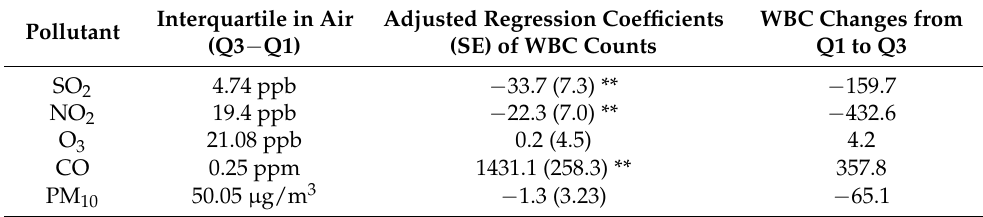
Table 6. Probable changes of WBC count influence by air pollutions in Kaohsiung